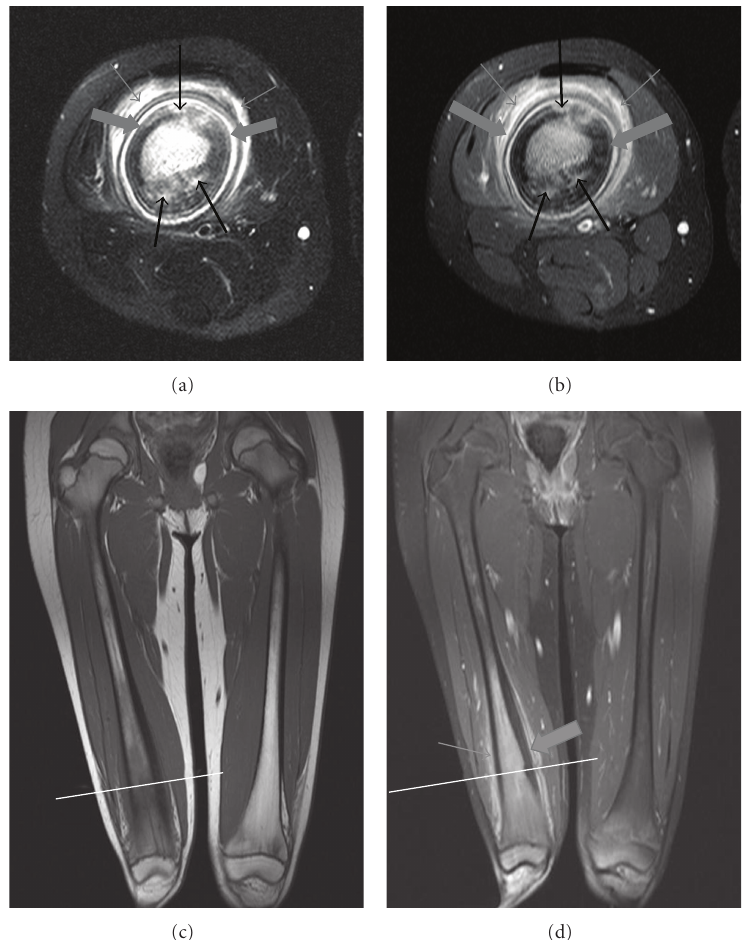
Figure 4: Axial (a-b) MRI through the right thigh with coronal (c-d) MRI images through both thighs. Displayed axial images are from the level of the white lines in (c) and (d). Sequences are as follows: (a) axial T2 fat saturated (FS) (TE 93ms. TR 5670 ms.), (b) axial T1FS with gadolinium (TE 17 ms. TE 730 ms.), (c) coronal T1 (TE 14 ms. TR 543ms.), and (d) coronal T1FS with gadolinium (TE 14ms. TR 460ms.). The axial T2 FS image displays the edematous high signal in the medullary space, patchy high signal cortical lesions (black arrows), cortical thickening and periosteal reaction (thick grey arrows), and subtle surrounding soft tissue edema (thin grey arrows). Coronal T1 (c) shows the low signal within the medullary space, a characteristic feature of involvement. After gadolinium (b,d) there is intense enhancement of the marrow, periosteum (thick grey arrows), with some enhancement also seen in the bordering musculature (thin grey